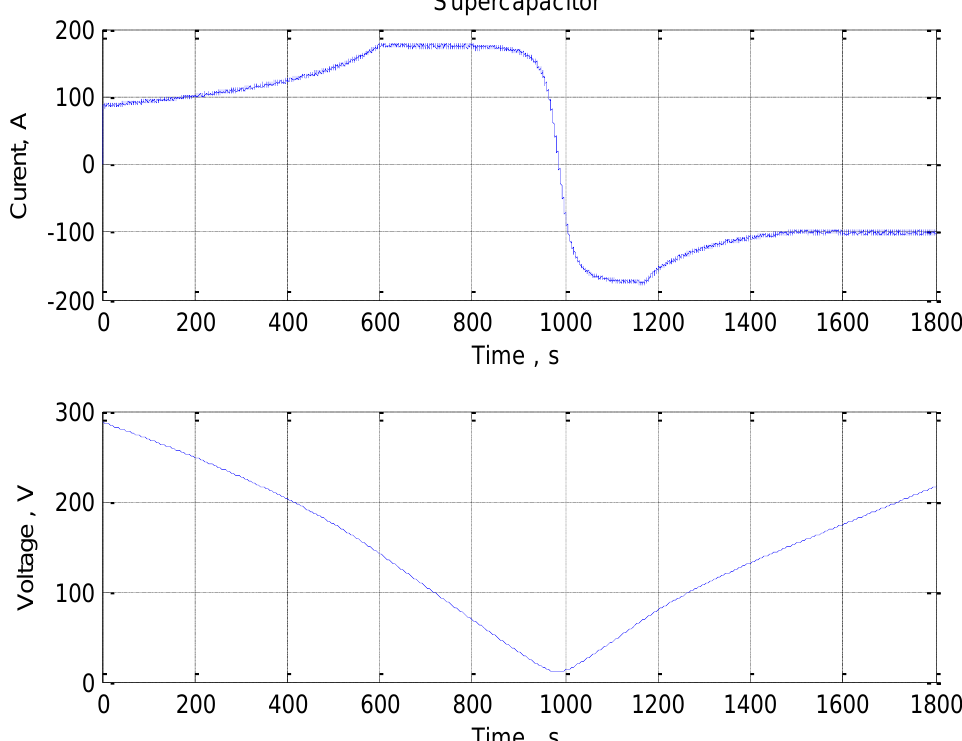
Figure 11. Voltages and current of supercapacitor.